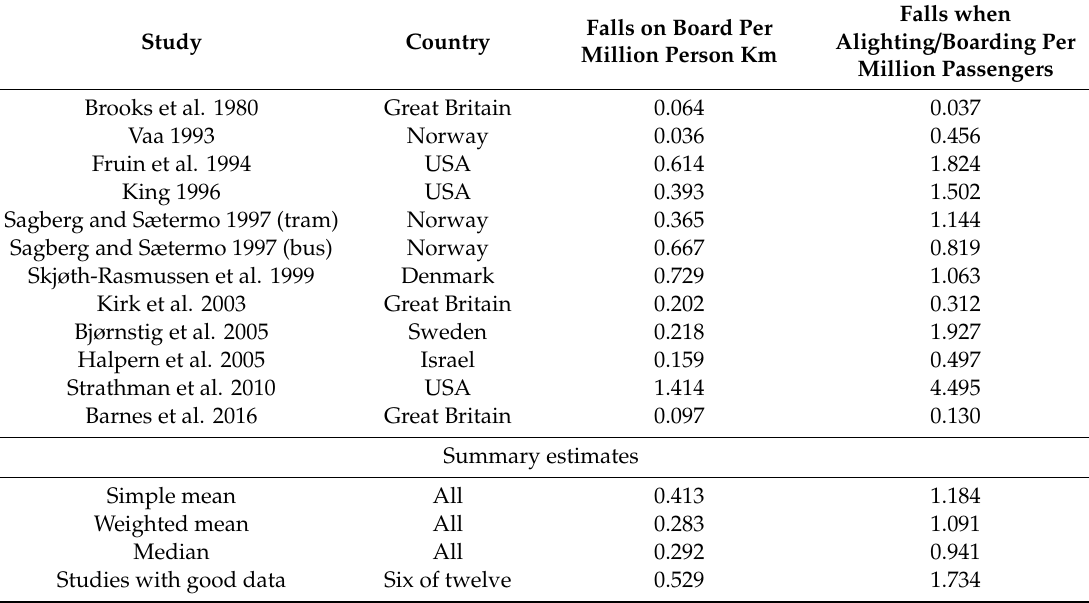
Table 2. Risk of injury to public transport passengers in non-collision events. Source: Elvik [3]. Study Country